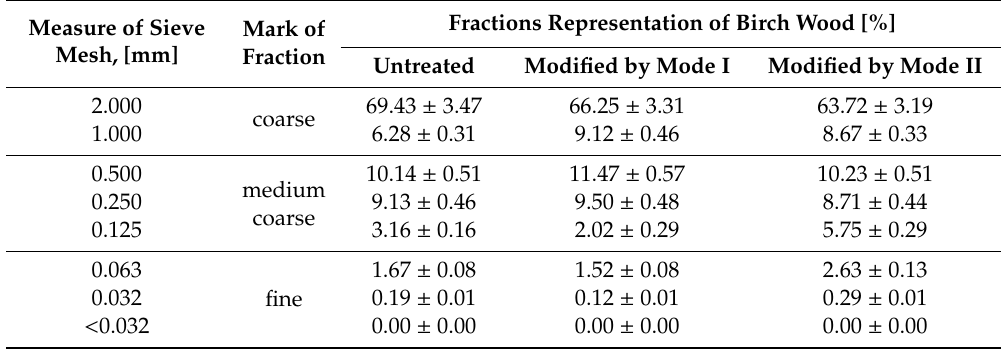
Table 6. Chips from the CNC machining centre SCM Tech Z5, average values with standard deviations. Fractions Representation of Birch Wood [%] Measure of Sieve Mark of Mesh, [mm] Fraction Untreated Modified by Mode I Modified by Mode II 2.000